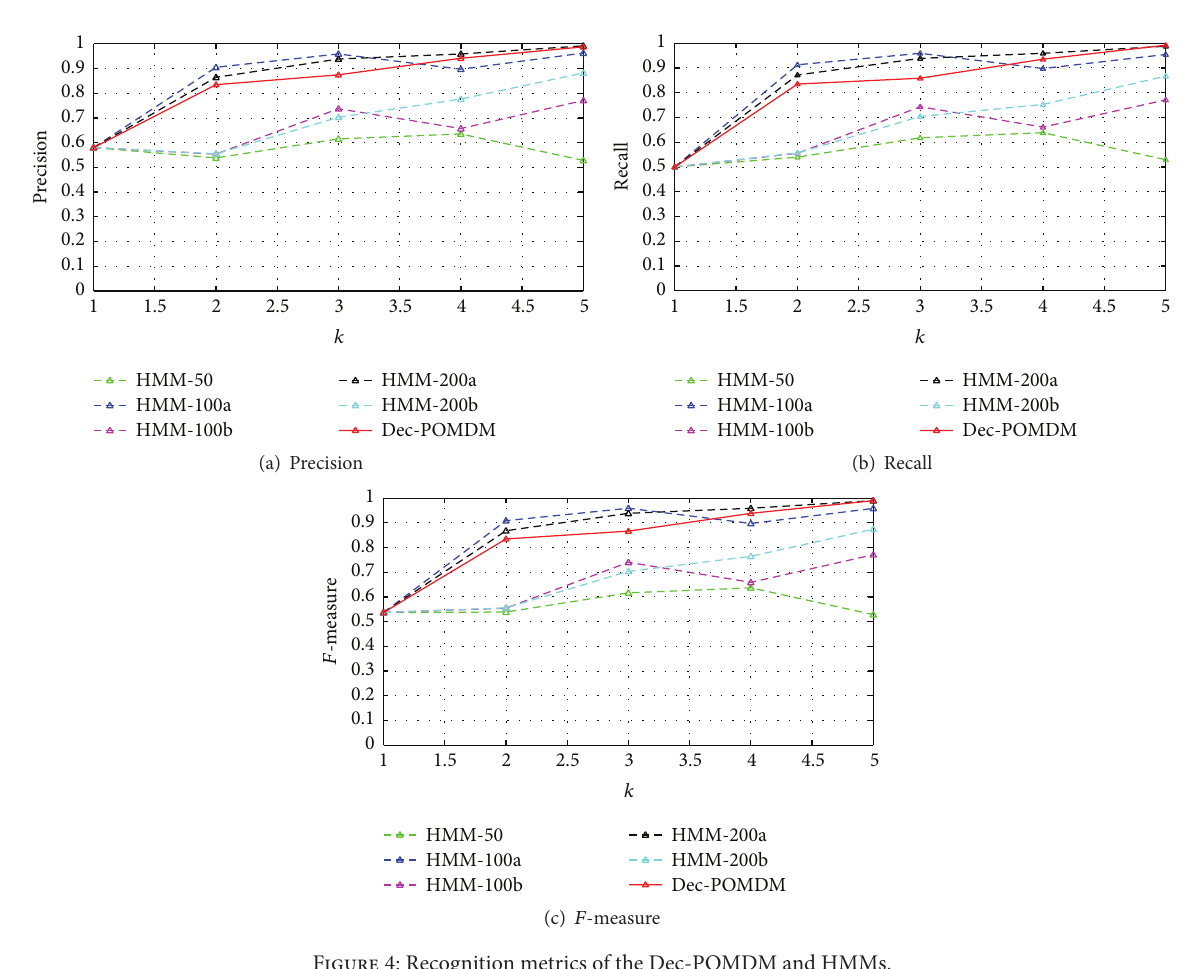
Figure 4: Recognition metrics of the Dec-POMDM and HMMs. Table 3: The 𝑝 values of the Wald test over the Dec-POMDM and HMMs. 𝑘 = 1 𝑘 = 2 𝑘 = 3 𝑘 = 4 𝑘 =